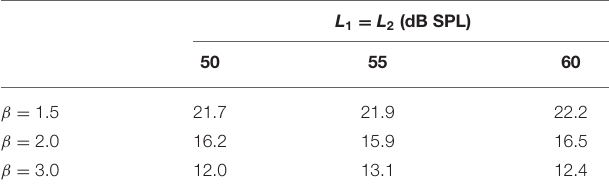
TABLE 1 | The suppression index K for different combination of